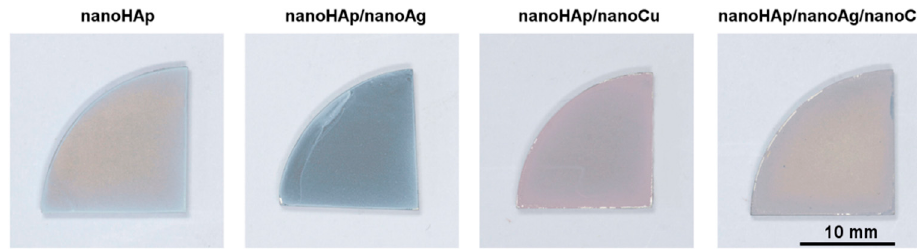
Figure 1. Nanohydroxyapatite-based coatings.